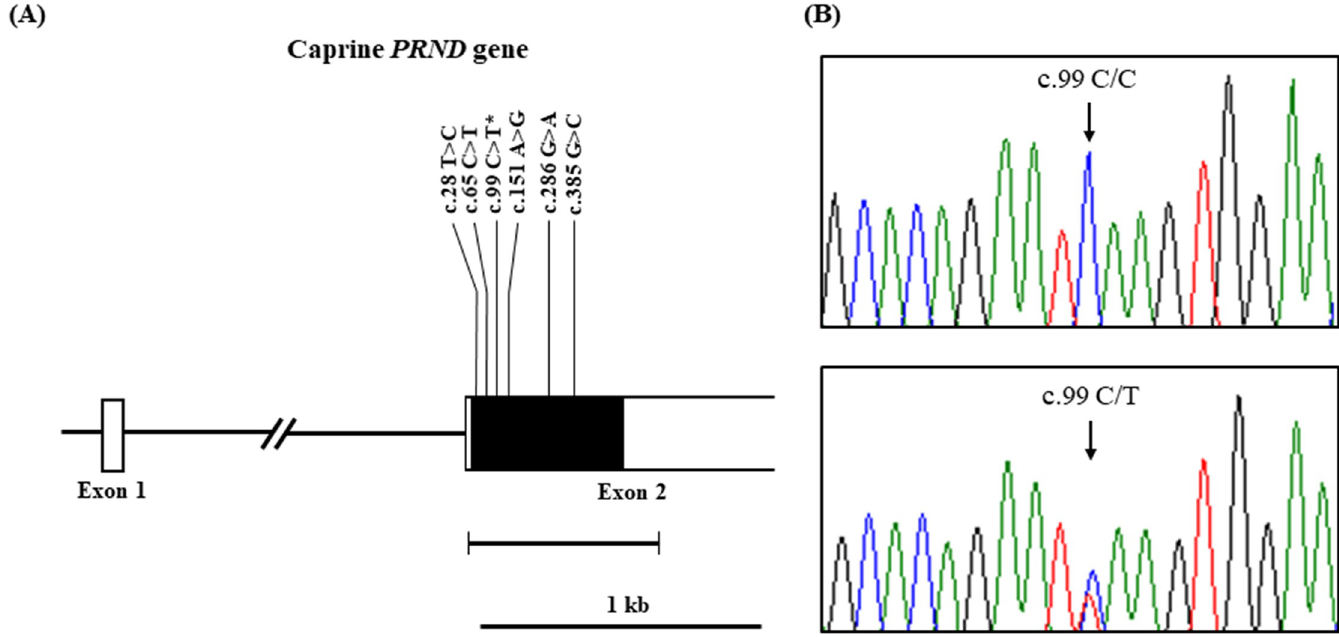
Fig 1. Genomic map and electropherograms of the single-nucleotide polymorphism (SNP) at c.99C > T of the caprine prion-like protein gene ( PRND ) in Korean native black goats. (A) Schematic diagram denotes the genomic structure of the caprine PRND gene, drawn to scale. The open reading frame (ORF) within exon 2 is indicated by the black box, and white boxes indicate the 5’ and 3’untranslated regions (UTRs). The edged horizontal bar indicates the regions sequenced. The bold text indicates the locations of the polymorphisms identified in this study. The asterisk indicates the novel SNP found in this study. (B) Electropherograms show two genotypes at c.99C > T of the caprine PRND gene in Korean native black goats. Upper panel, homozygote CC genotype; lower panel, heterozygote CT genotype. The homozygote TT genotype was not detected.